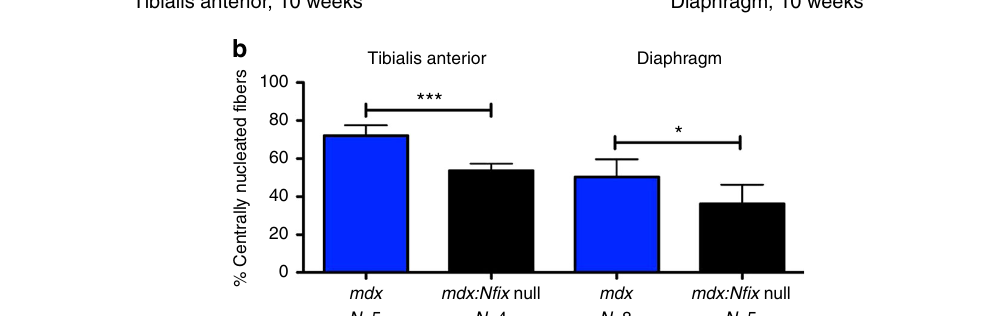
Sgca null: Mlc1f-N fi x2 mice belonging to class 1 – 4. Histological